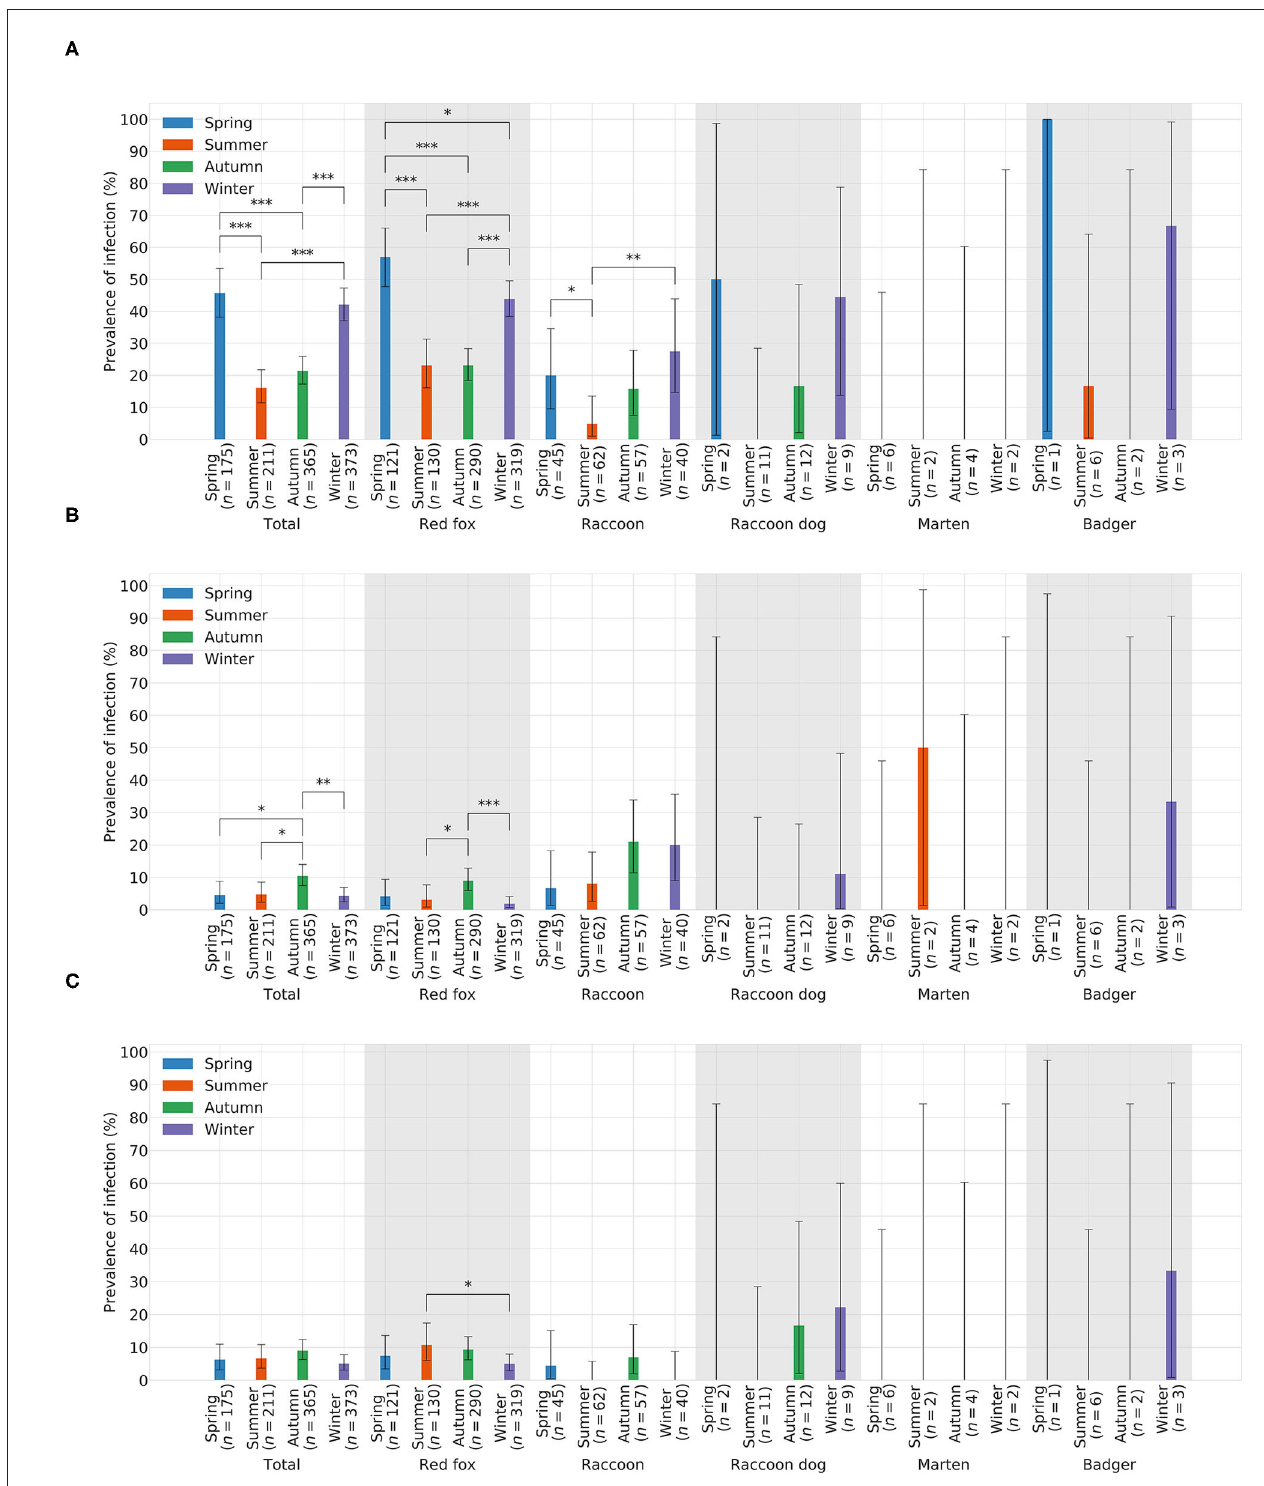
FIGURE 4 | Prevelances of (A) CDV, (B) CPV-2, and (C) FoxCV by season. Error bars indicating 95% confidence intervals (CIs). Significant p -values are indicated as follows: * p ≤ 0.05; ** p ≤ 0.01; *** p ≤ 0.001. Number of animals sent in ( n ).